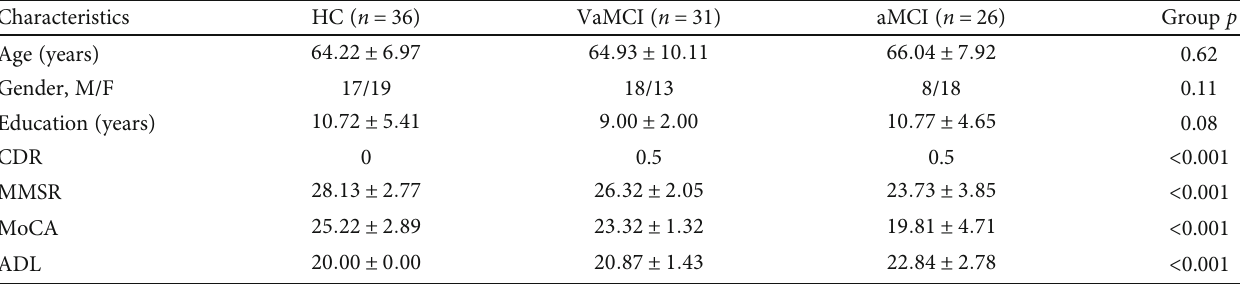
Table 1: Clinical characteristics of subjects with aMCI and VaMCI and HC.